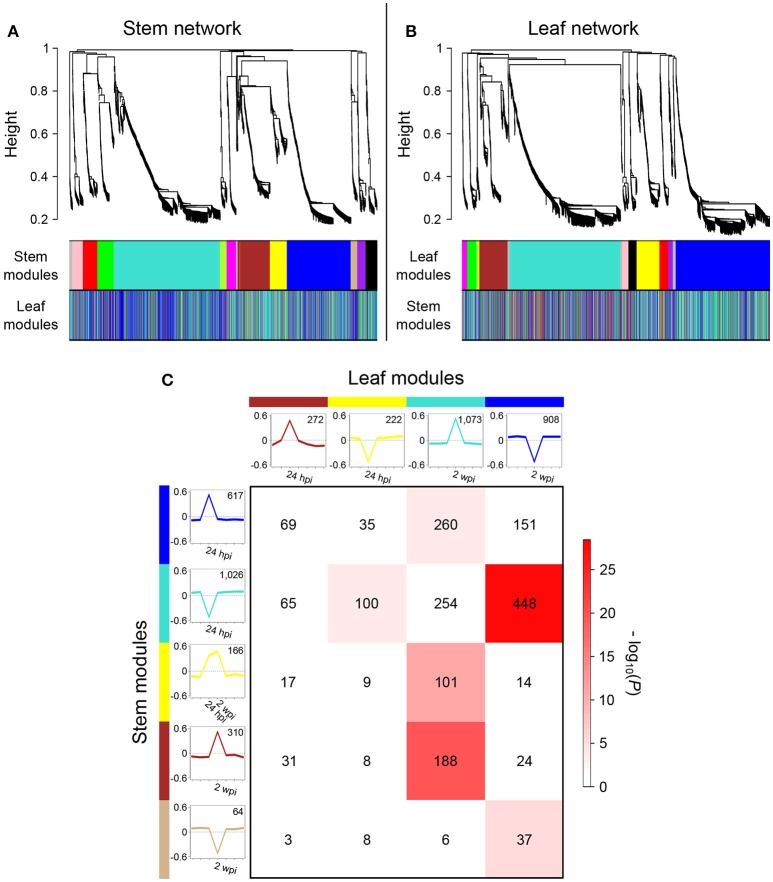
Comparison of stem and leaf co-expression networks. (A) Hierarchical clustering tree (dendrogram) of genes based on stem network. Each short vertical line corresponds to one gene. The colored rows below the dendrogram indicate module membership in the stem modules and in the leaf network. (B) Hierarchical clustering tree of genes based on the leaf network. The color rows below the dendrogram indicate module membership in the leaf modules and in the stem network. (C) Cross-tabulation of stem (rows) and leaf modules (columns) showing a transcriptional modulation at 24 hpi and 2 wpi. Each row and column is represented by the corresponding module color. In the table, numbers give counts of genes in the intersection of the corresponding row and column module. The table is color-coded by -log(P), the Fisher exact test P-value, according to the color legend on the right. For each module, the eigengene expression profile is color-coded with the corresponding module color and the module size is indicated. The eigengene can be interpreted as a weighted average gene expression profile (Langfelder et al., 2011).